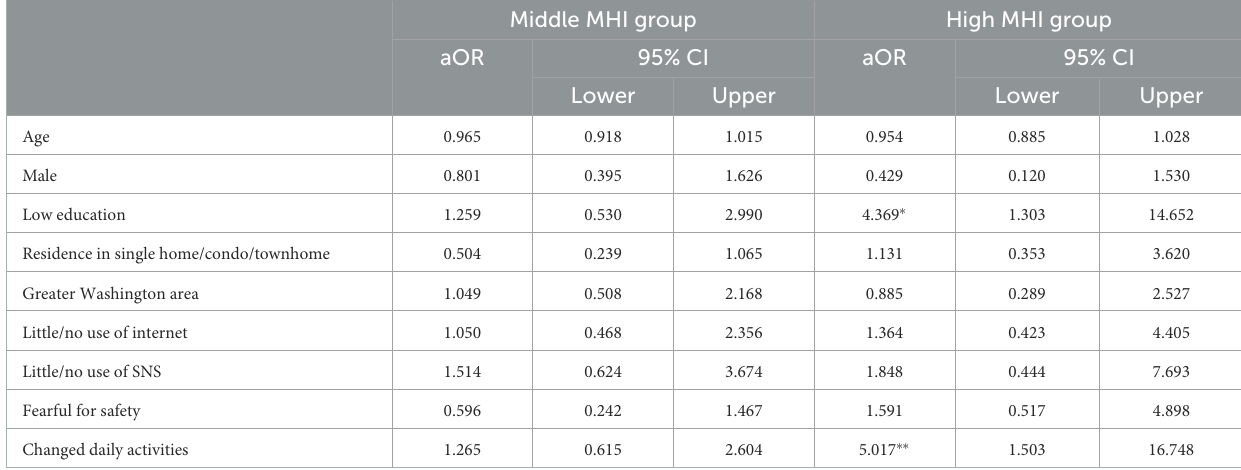
TABLE 3 Results from multinomial logistic regression